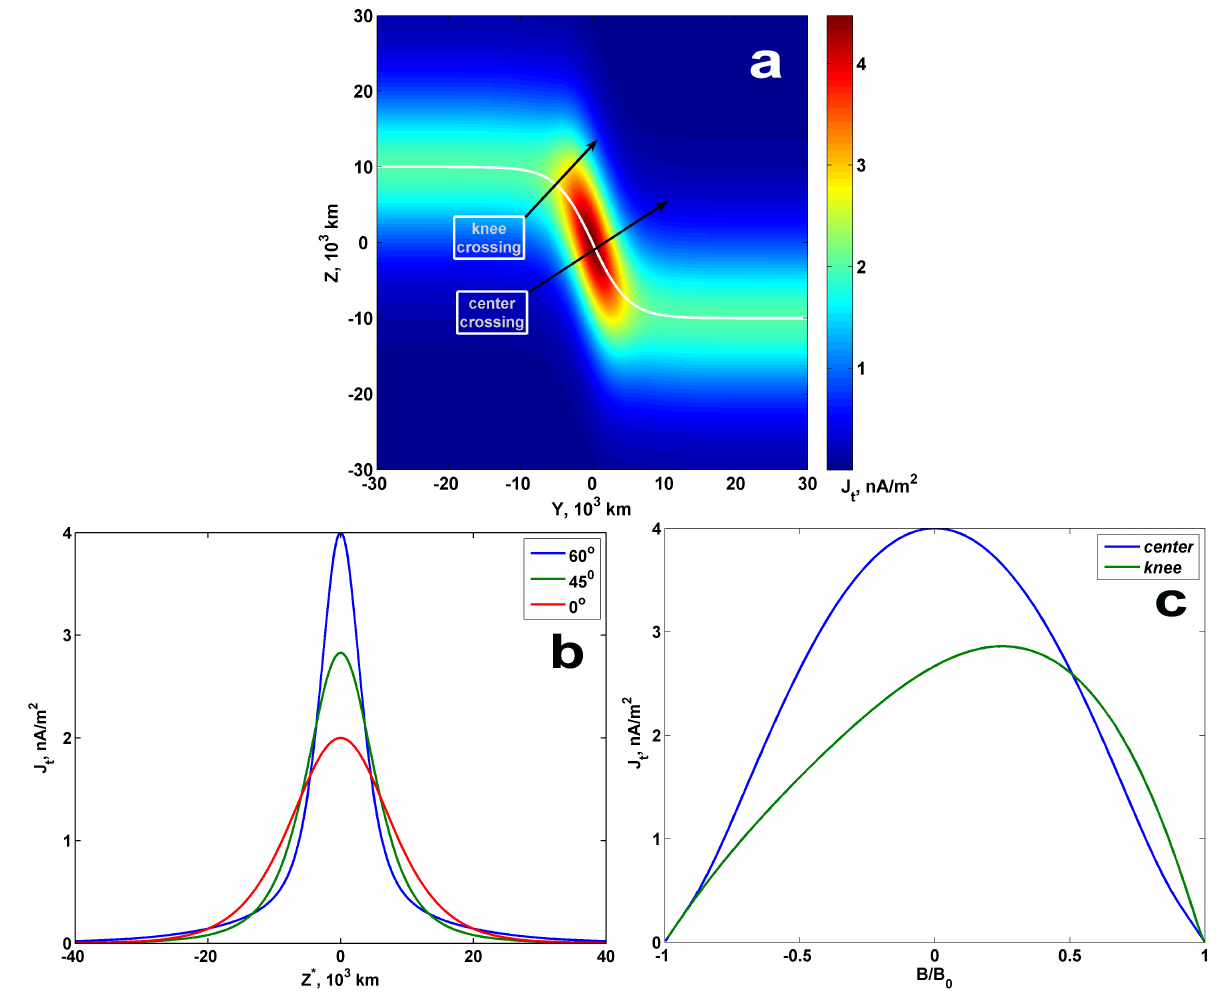
Fig. 3. The model kinked current sheet (see text for details). (a) Total current density map and the neutral sheet plane (white curve). Two trajectories of a virtual spacecraft denote a “center crossing” and a “knee crossing”. (b) Total current density profiles relative to distance along the normal for a “center crossing” for different tilts of the sheet. (c) Nonsymmetric total current density profile relative to the local magnetic field during the “knee crossing” , compared with the “center crossing” for the 60 ◦ tilt